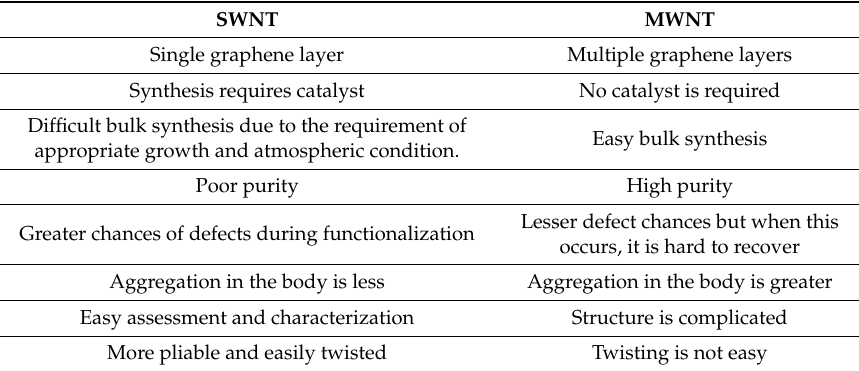
Table 1. Comparison between SWCNTs and MWCNTs [23].